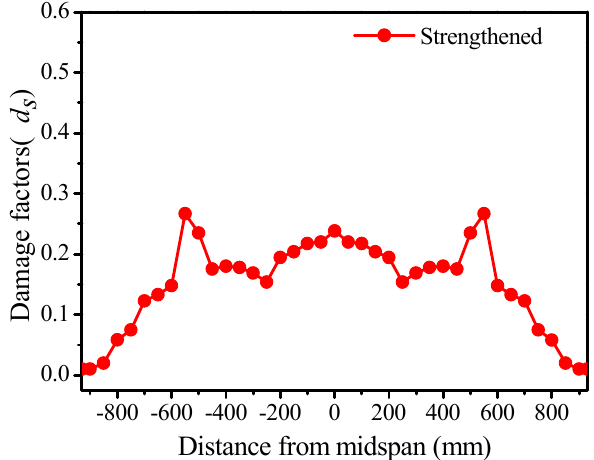
Figure 9. Sectional damage factors of the CFRP-strengthened T-beam.